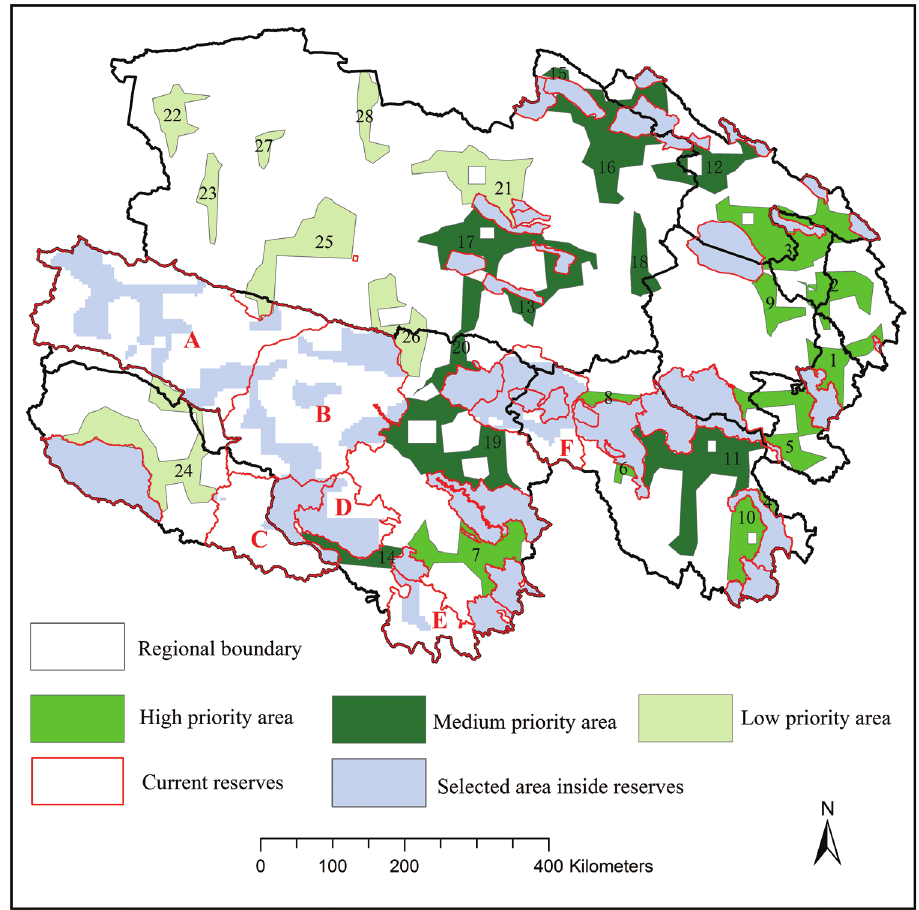
Figure 3. Spatial distribution of proposed priority areas (including high, medium and low priorities) inside and outside the existing nature reserves for Qinghai